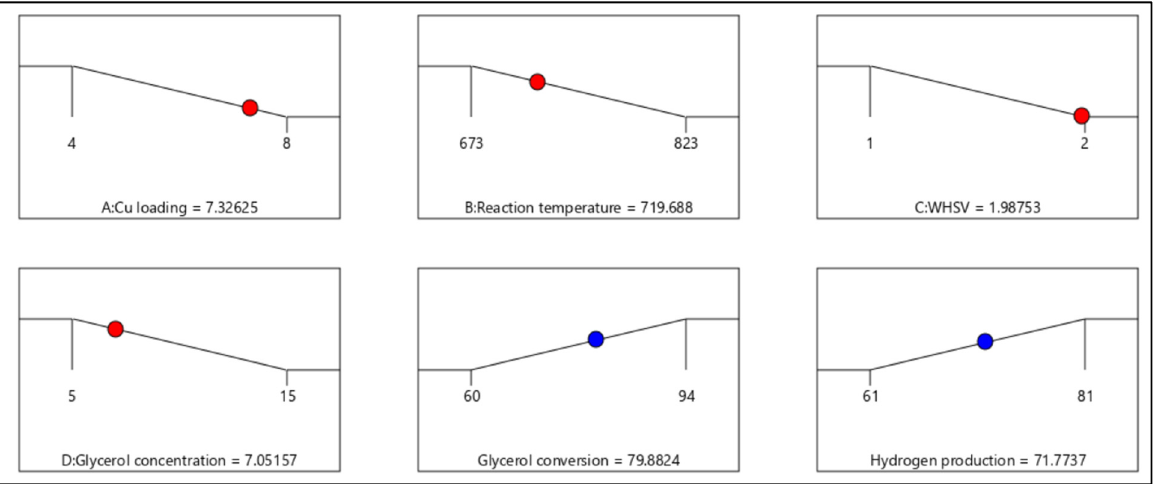
Figure 4. Predicted dual criteria optimisation results for the model (red: independent variable; blue: predicted results).